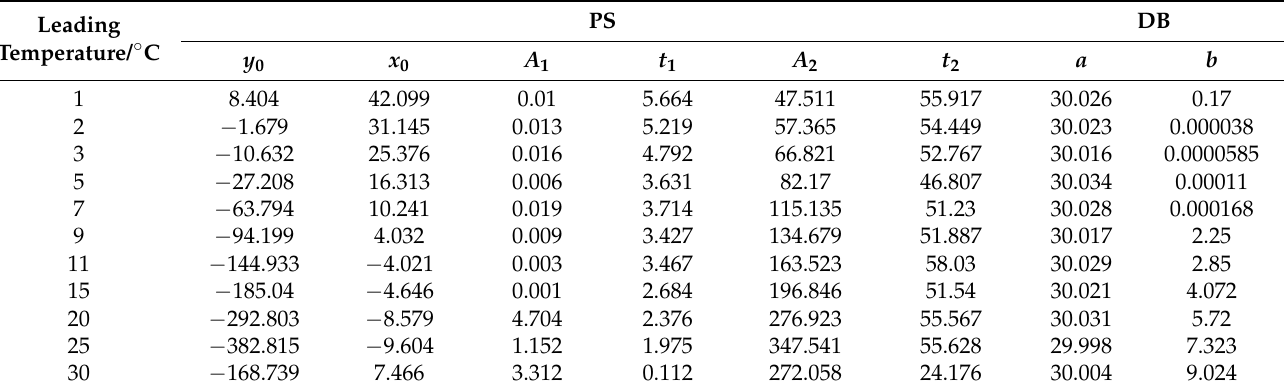
Table 4. Temperature function fit